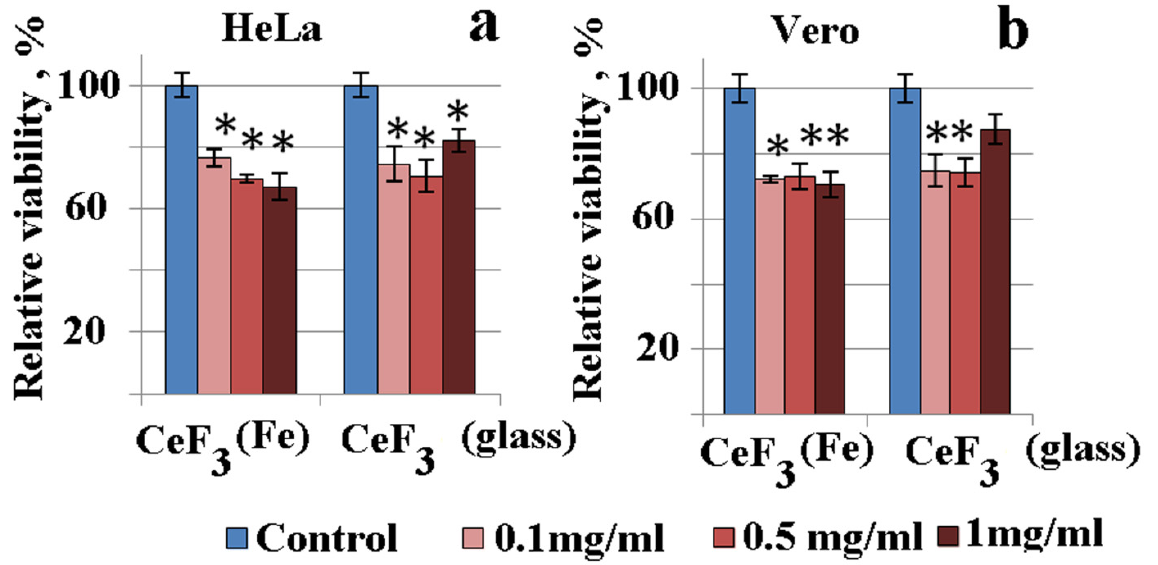
Figure 8. Change in cell viability when adding CeF 3 and CeF 3 nanopowders (from glass): ( a ) HeLa cell culture; ( b ) Vero cell culture (*-difference with control is significant ( p < 0.05)).